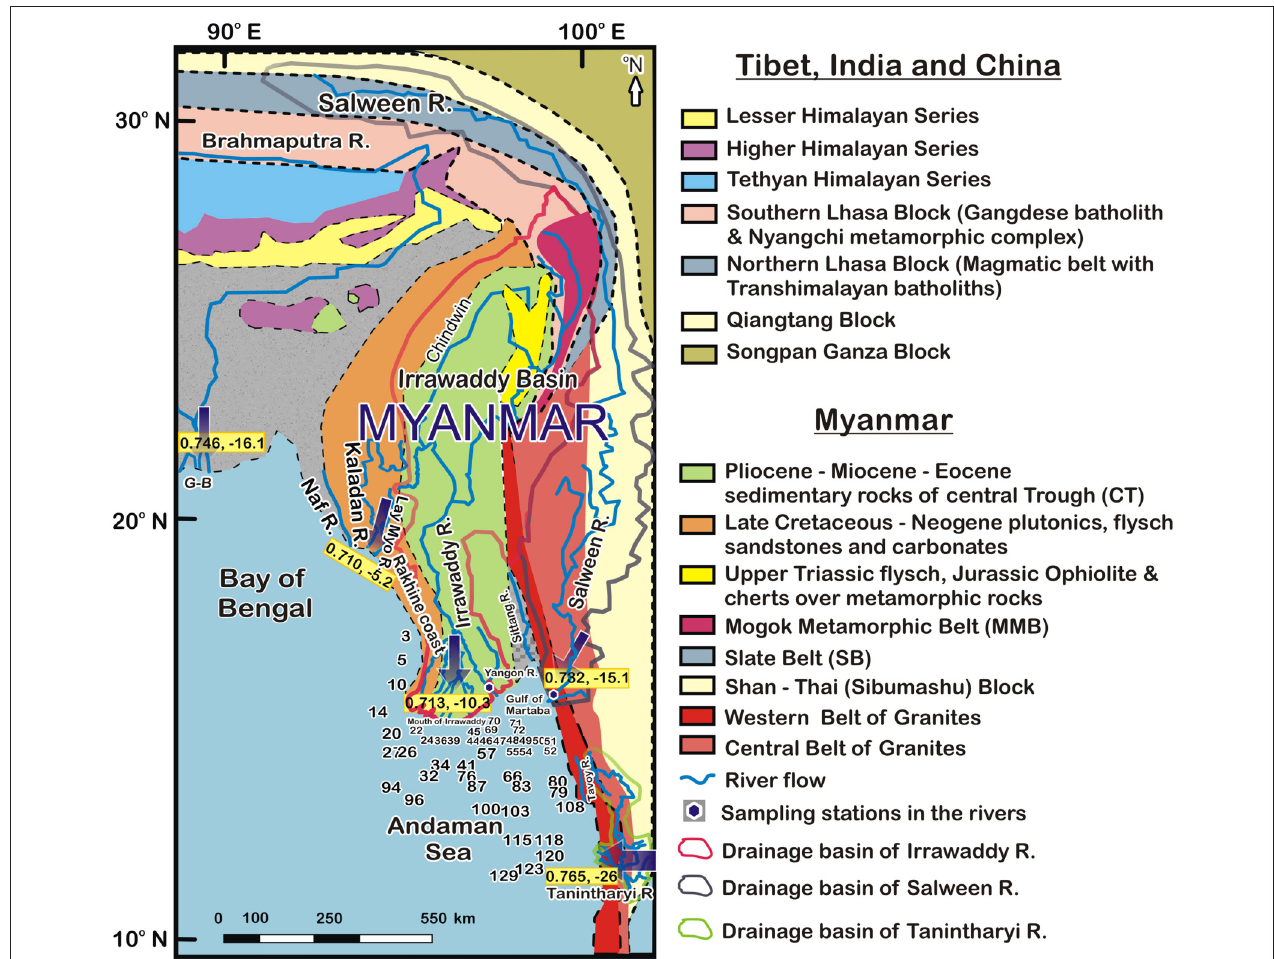
FIGURE 3 | The lithology map of the drainages of the Irrawaddy, the Salween and the Tanintharyi River basins falling in the Tibet, China, and the Myanmar, modified after (Awasthi et al., 2014; Chapman et al.,